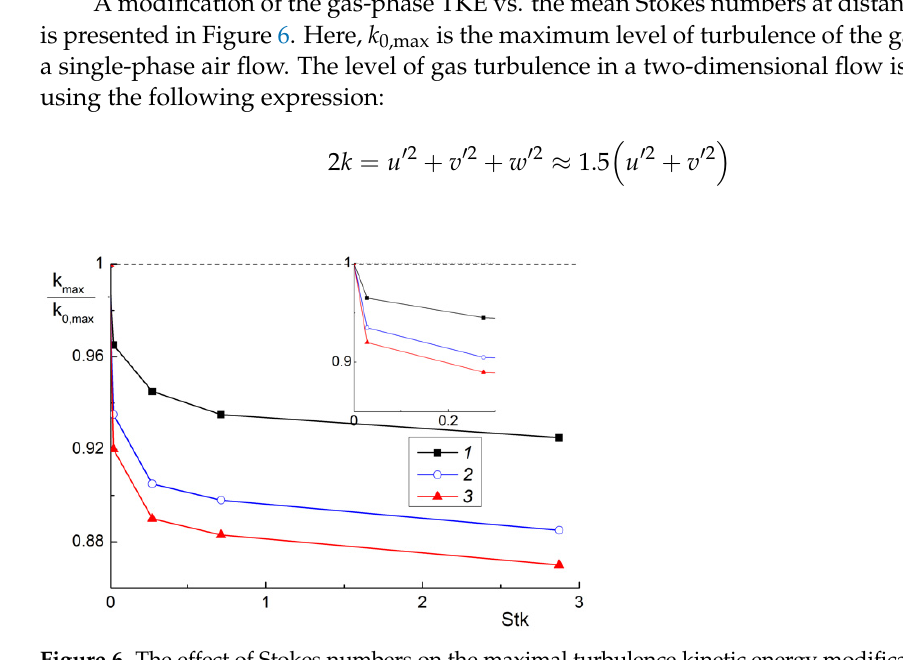
Figure 7. The TKE modification ratio vs. Stokes numbers at a few stations from the wall surface. x / H = 2, M L 1 = 0.05. 1: y / H = 0.1; 2: 0.5; 3: 1.